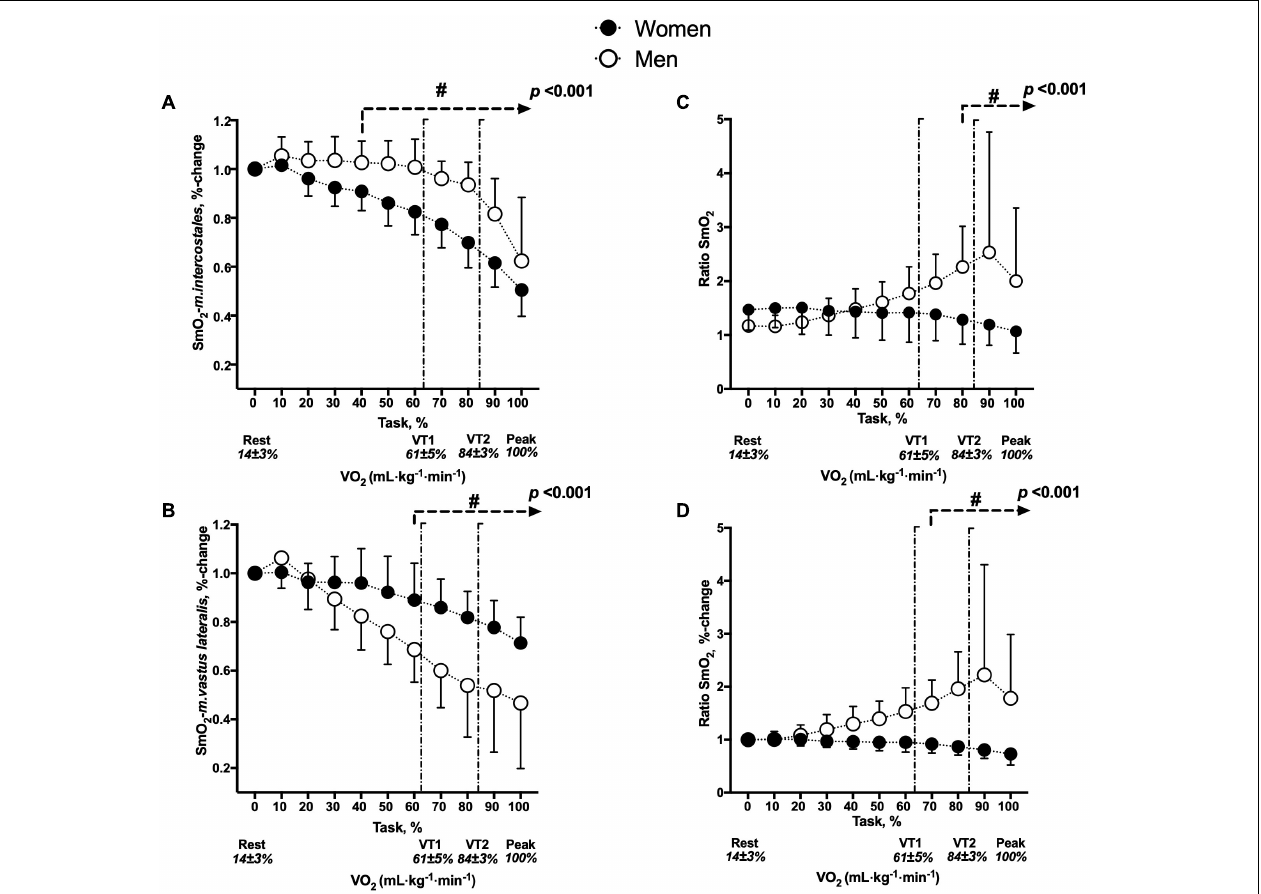
FIGURE 2 | Changes in SmO 2 between men and women. (A) SmO 2 - m.intercostales (%-change), (B) SmO 2 - m.vastus lateralis (%-change), (C) SmO 2 ratio (absolute values) and (D) SmO 2 ratio (%-change). # p < 0.05: comparison between sex with respect to percentage of task. The two vertical lines represent ventilatory thresholds (VT1, 61 ± 5% to VO 2 - peak and VT2, 84% ± 3% to VO 2 - peak ). The interaction between factors (sex × time) is represented by the p- value.